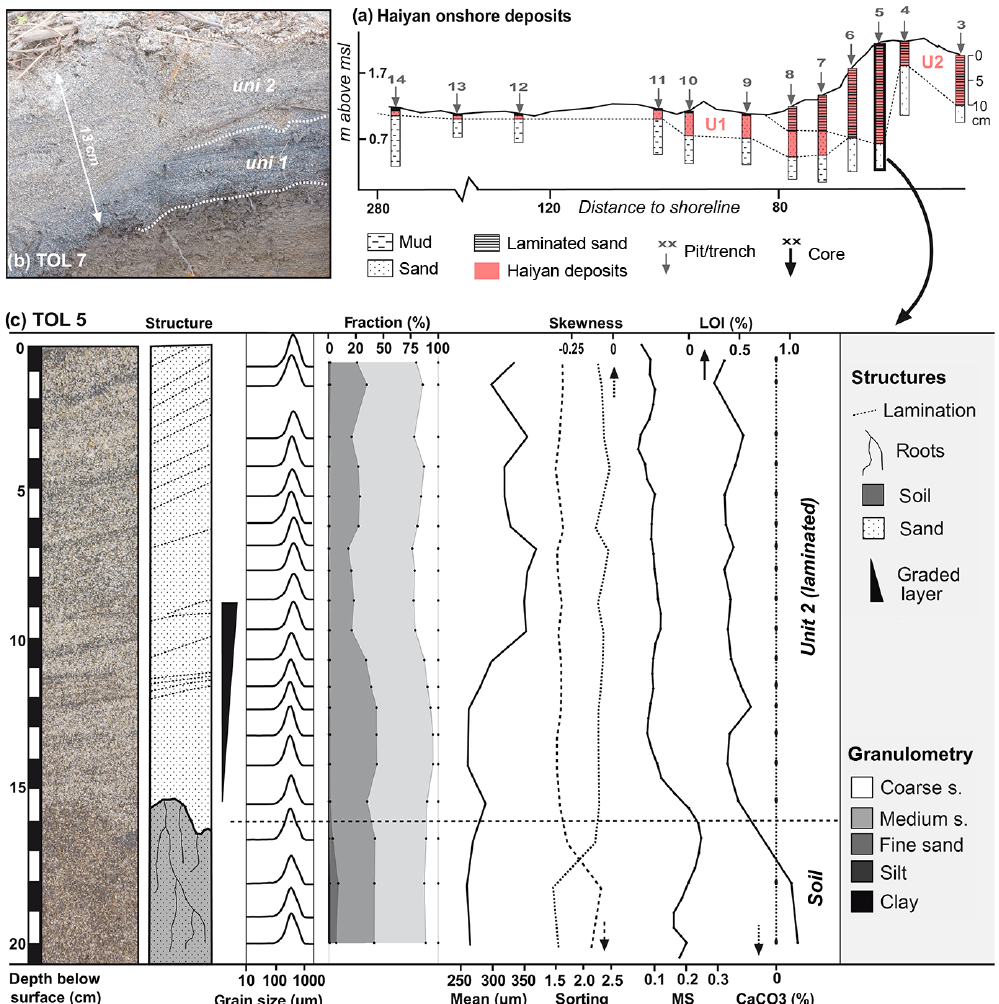
Figure 6. Typhoon Haiyan onshore deposits at site TOL. (a) Transect illustrating the succession of typhoon deposits in landward direction. A graded to massive basal unit (U1) is covered by a laminated unit (U2) in the proximal part of the coastal plain (TOL 3–8). (b) The 10cm thick deposit at TOL 7 consists of massive sand at the base (unit 1) and laminated sand on top (unit 2). (c) Sedimentary characteristics of TOL 5. The 16cm thick laminated typhoon layer can clearly be separated from the palaeosol due to lower LOI and magnetic susceptibility